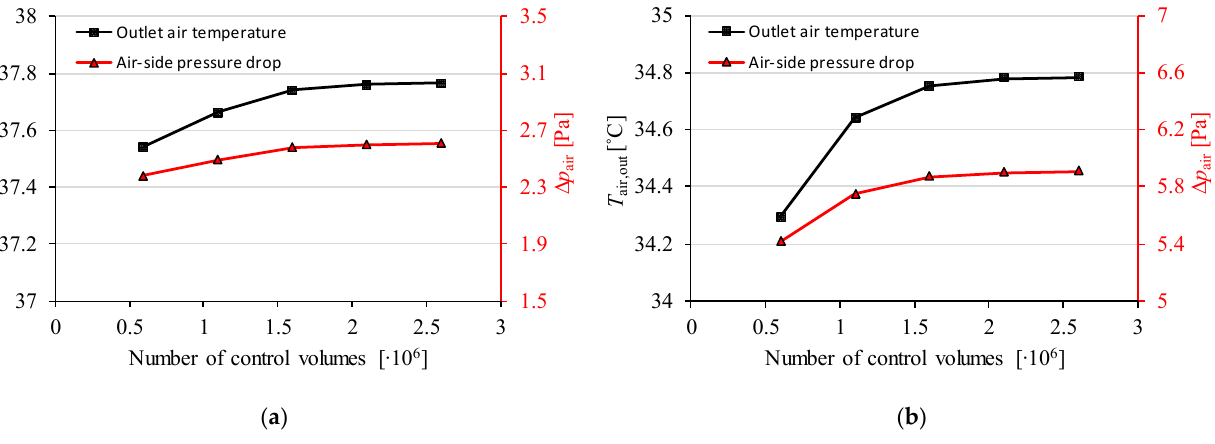
Figure 7. Mesh size independence results for air-to-water FTHEX with DWD vortex generators and α vg = 30°. Test conditions: ( a ) w air,in = 0.46 m/s, T air,in = 22 °C, T water,in = 40 °C, w water,in = 0.76 m/s; ( b ) w air,in = 0.859 m/s, T air,in = 22 °C, T water,in = 40 °C, w water,in = 0.76 m/s.